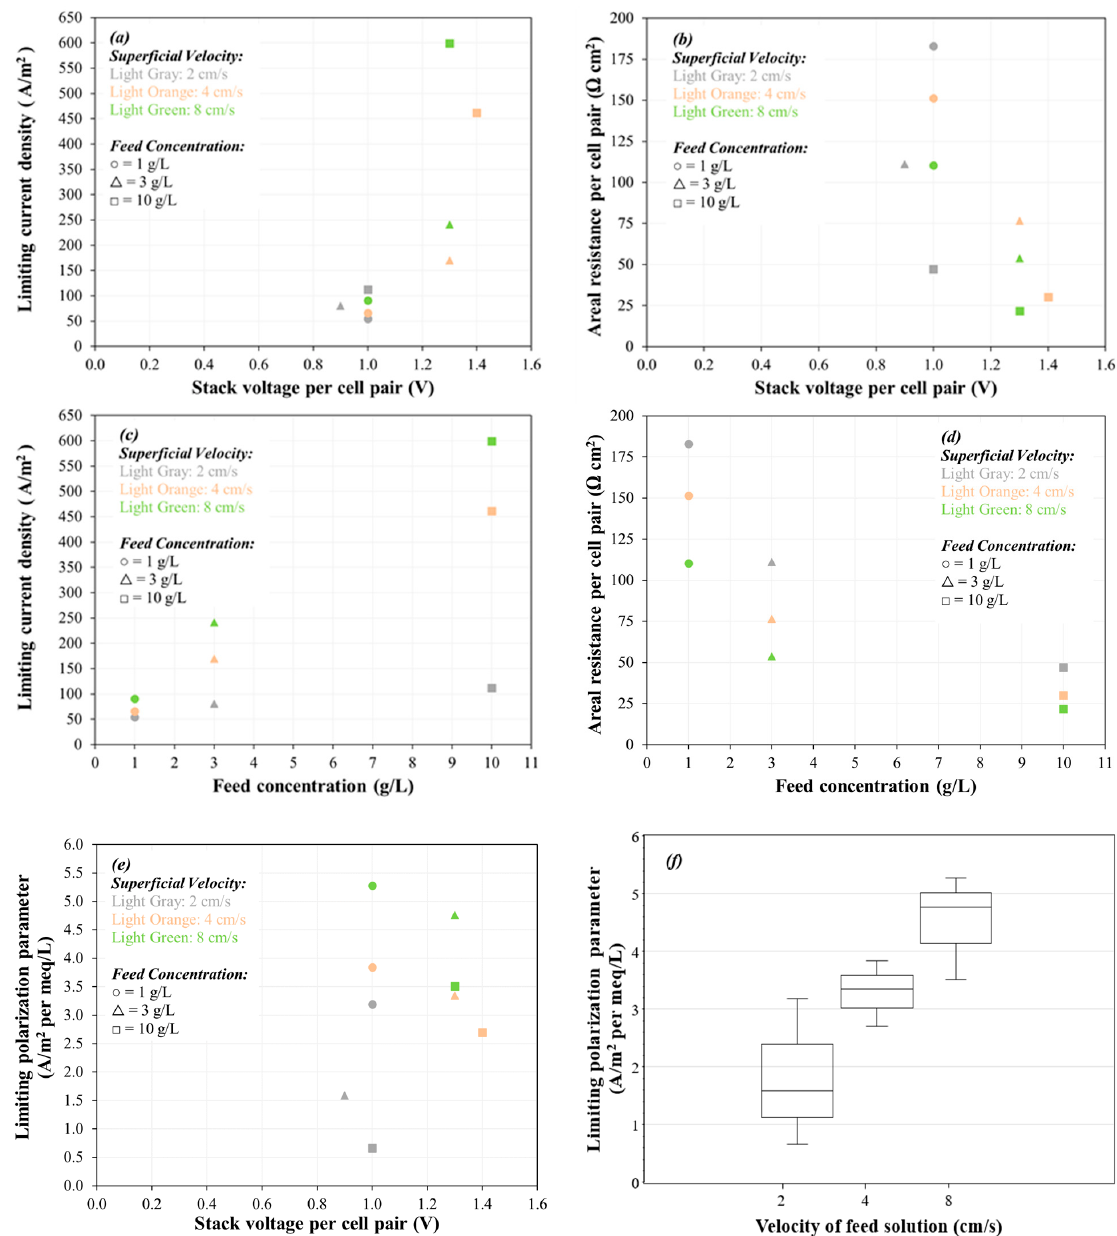
Figure 3. Limiting current density ( a , c ), areal resistance ( b , d ), and limiting polarization parameter ( e , f ). Experimental con- ditions: Five cell-pairs AMX/CMX stack; 2–8 cm/s superficial velocity; constant stack voltage application; 0.1 M (14.2 g/L) Na 2 SO 4 electrode rinse solution; and 3 kPa transmembrane